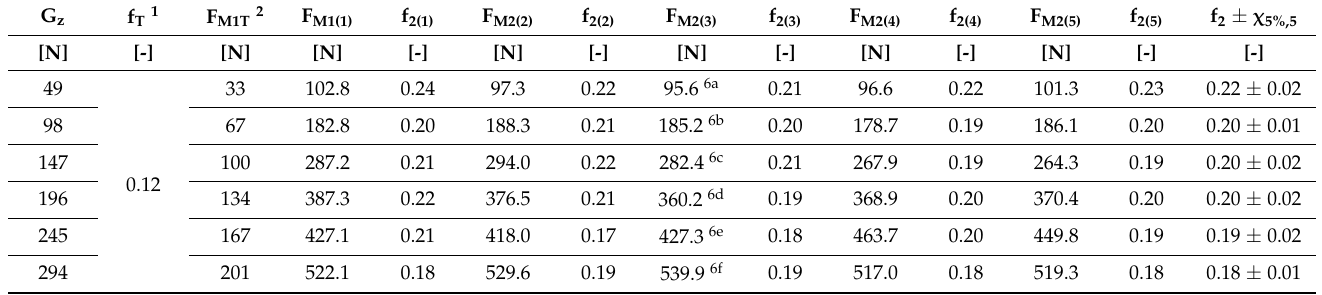
Table 6. Tensile force F M2(i) [N], φ 8 mm rope, semi-circular groove, contaminated with oil.